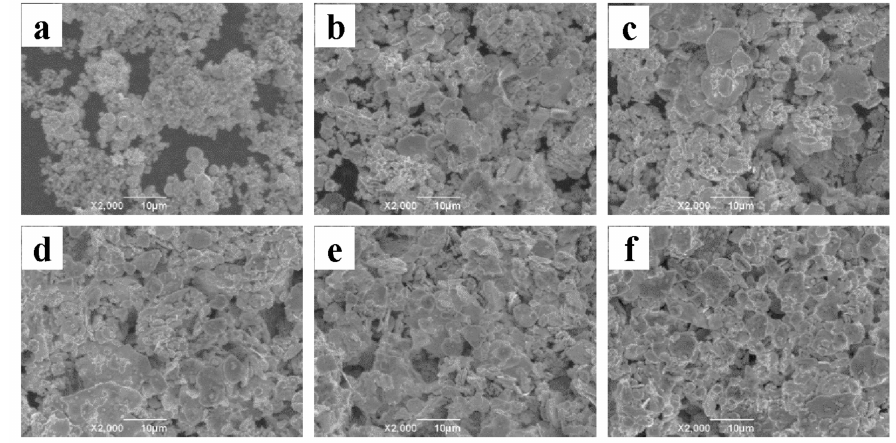
Figure 2. SEM images of W-6Ni-4Co alloy milled powders: ( a ) 0 h, ( b ) 5 h, ( c ) 10 h, ( d ) 15 h, ( e ) 20 h, ( f ) 25